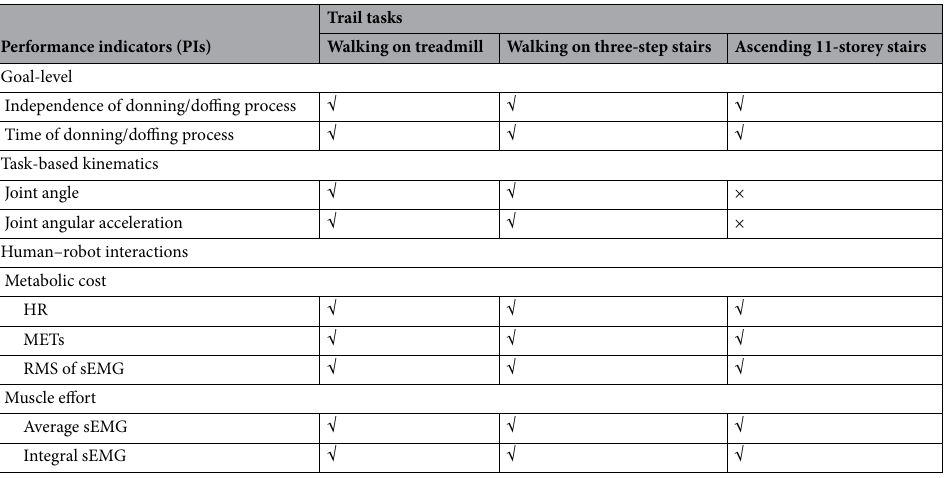
Table 2. PIs characterized with three trial tasks. “√” indicates that the PI at that trial task was recorded, and “×” indicates that the PI at that trial task was not collected due to instrument